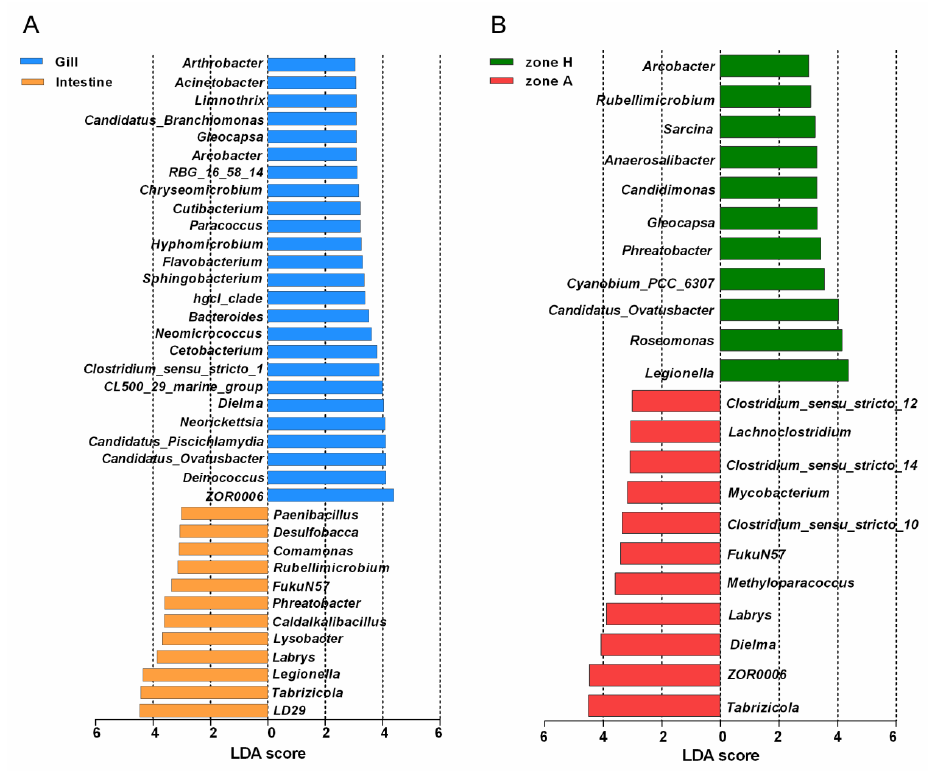
Figure 6. LDA score bar plots showed discriminative taxa (LDA score >3, p < 0.05) of microbiota at the genus level. ( A ) LDA score bar plots displayed discriminative microbial genera between fish gills and intestines; ( B ) LDA score bar plots displayed discriminative microbial genera between fish from two zones.